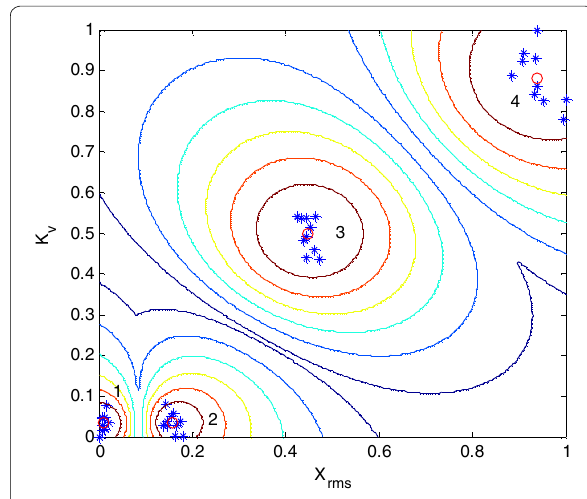
Figure 7 FCM cluster result